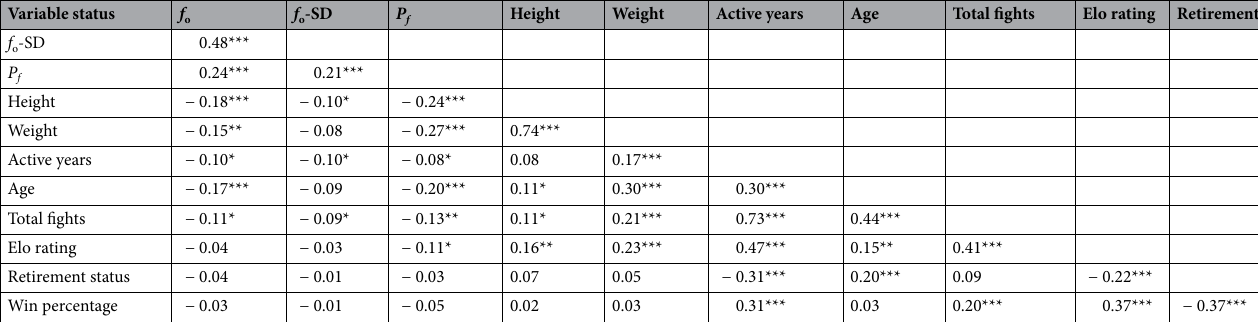
Table 1. Zero-order correlations among study variables. Acoustic variables are computed as the best linear unbiased measures for multiple recordings measured at the individual level by using micro-macro multi-level modeling 73 , which is preferred to using simple group means 74 . p < .05*, p < .01**, p < .001 ***.